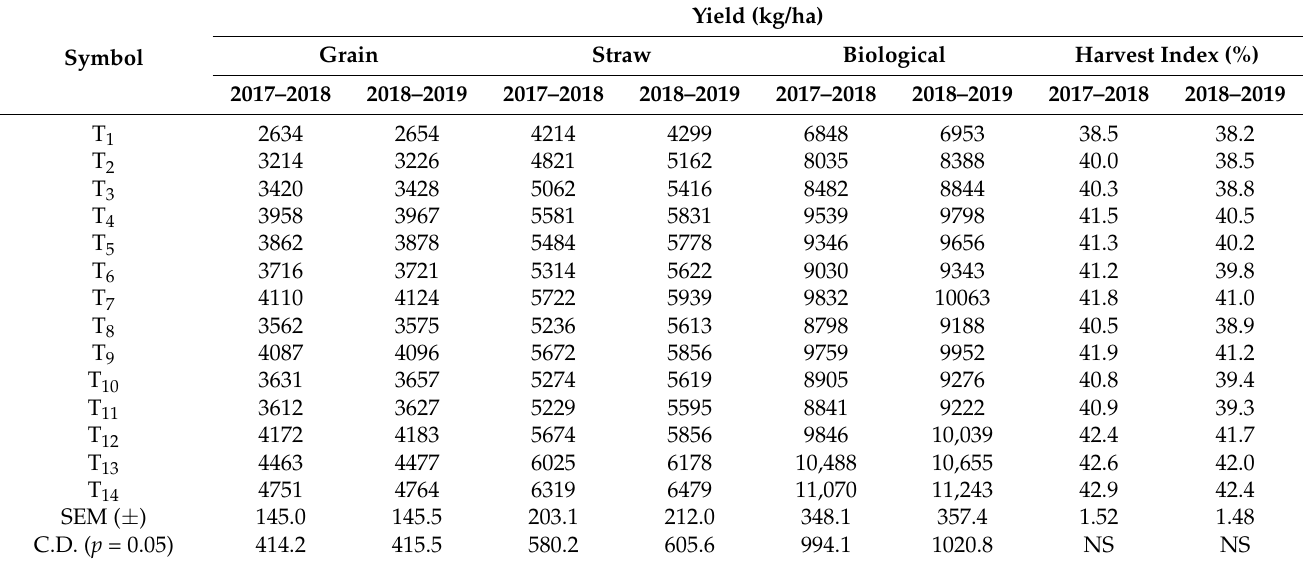
Table 4. Nutrient management strategies effects on crop yield